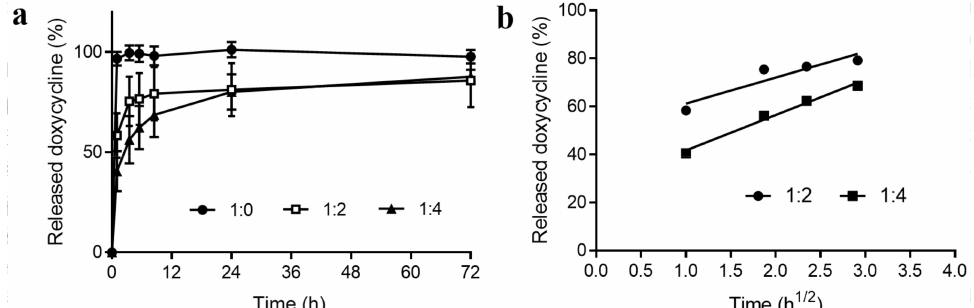
Figure 4. The in vitro drug release from the single and core-shell nanofiber was estimated by the conventional method. ( a ) Release profiles of doxy from single (1:0) and core-shell (1:2, 1:4) nanofibers in phosphate bu ff er adjusted to pH 7.4. The release medium was maintained at 37 ◦ C. The amount of doxy was measured by HPLC (high performance liquid chromatography). ( b ) Higuchi modeling of doxy release from core-shell (1:2, 1:4) nanofibers. Solid lines are a regression curve for the Higuchi equation. r 2 and other statistical values are listed in